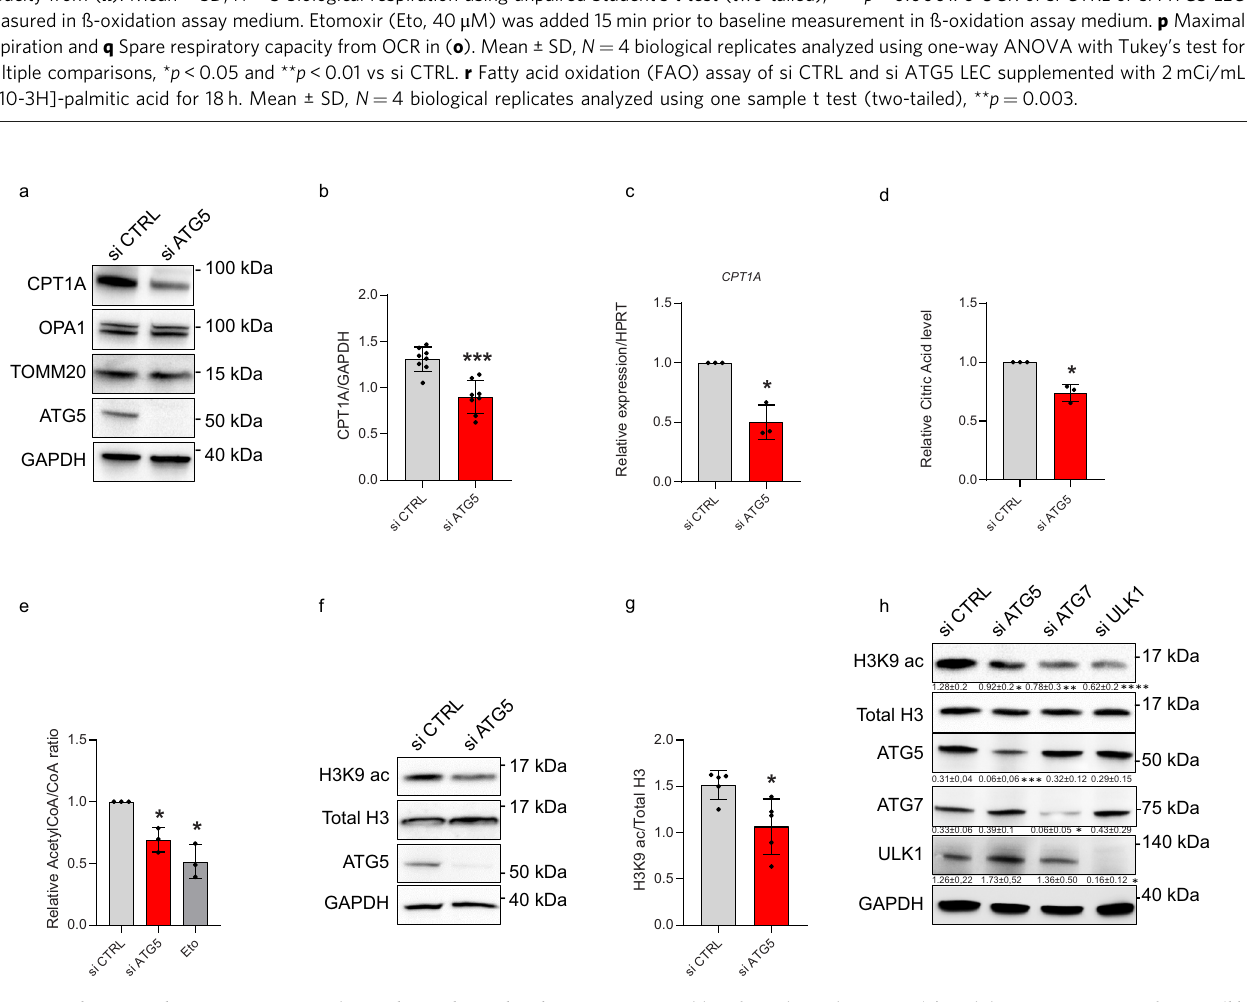
Fig. 5 Autophagy regulates CPT1A expression and acetyl-CoA levels. Representative blots for indicated proteins ( a ) and densitometric quanti fi cation ( b ) of CPT1A levels in si CTRL or si ATG5 LEC. Mean ± SD, N = 3 biological replicates analyzed using unpaired Student ’ s t test (two-tailed), *** p = 0.0001. c RT-qPCR analysis of si CTRL and si ATG5 LEC. mRNA expression of CPT1A (relative to HPRT). Mean ± SD, N = 3 biological replicates analyzed using one sample t test (two-tailed), * p = 0.03. d Relative Citric acid levels in si CTRL and si ATG5 LEC measured via mass spectrometry. Mean ± SD, N = 3 biological replicates analyzed using one sample t test (two-tailed), * p = 0.03. e Relative acetyl CoA/CoA ratio measured via mass spectrometry in si CTRL, si ATG5, or etomoxir (Eto, 100 µ M, 48 h) treated LEC. Mean ± SD, N = 3 biological replicates analyzed using one way ANOVA with Tukey ’ s test for multiple comparisons, * p < 0.05 vs si CTRL. Representative blots ( f ) and densitometric quanti fi cation ( g ) for H3K9 ac levels relative to total H3 of si CTRL and si ATG5 LEC. Mean ± SD, N = 5 biological replicates analyzed using unpaired Student ’ s t test (two-tailed), * p = 0.02. h Representative blots for indicated proteins with GAPDH as loading control of si CTRL, si ATG5, si ATG7, or si ULK1 LEC. Densitometric quanti fi cation is indicated beneath the blots (H3K9 ac levels relative to total H3 and ATG5, ULK1, and ATG7 levels relative to GAPDH). Mean ± SD, N ≥ 3 biological replicates analyzed using one way ANOVA with Tukey ’ s test for multiple comparisons, * p < 0.05, ** p < 0.01, *** p < 0.001 and **** p < 0.0001 vs si